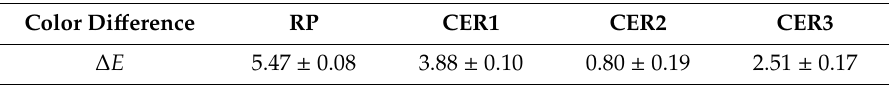
Table 4. Total color di ff erence, ∆ E , values as a result of self-cleaning behavior of coatings according to the recovery of their original colors.